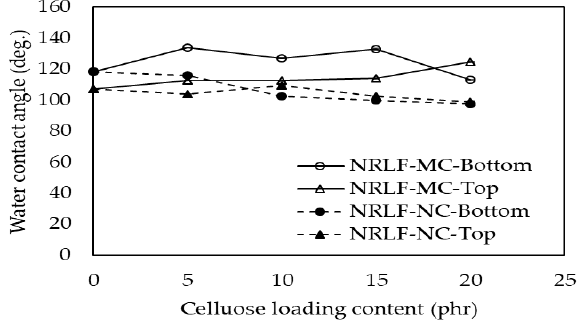
Figure 8. Water contact angle on the bottom and top surfaces of NRLF, NRLF-MC and NRLF-NC. 378